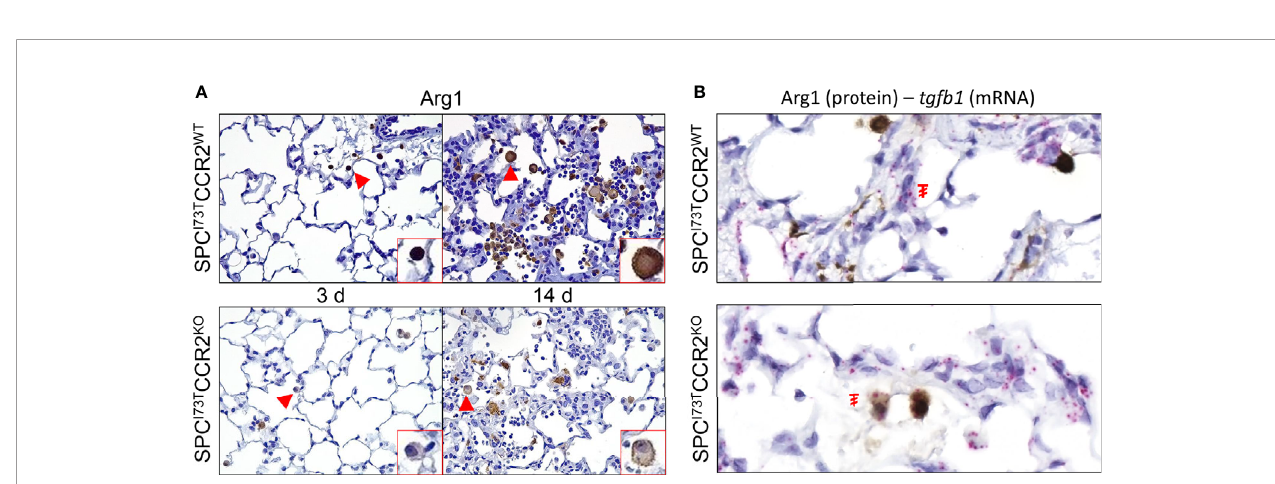
FIGURE 10 | Effects of CCR2 monocyte ablation on anti-in fl ammatory activation following SP-C I73T induced injury. Histochemical analysis alone or in combination with in situ hybridization of SP-C I73T CCR2 WT and SP-C I73T CCR2 KO lung following SP-C I73T induced injury. Sections were immunostained with antibody to (A) Arg1 or (B) Arg1+ Tgfb1 . mRNA visualization is shown in pink. Protein expression was visualized using a DAB Vectastain kit (brown). Arrowheads indicate cells expressing the receptor. ₮ indicate mRNA expressing cells. Original magni fi cation, 1000x. Representative region is shown (N =